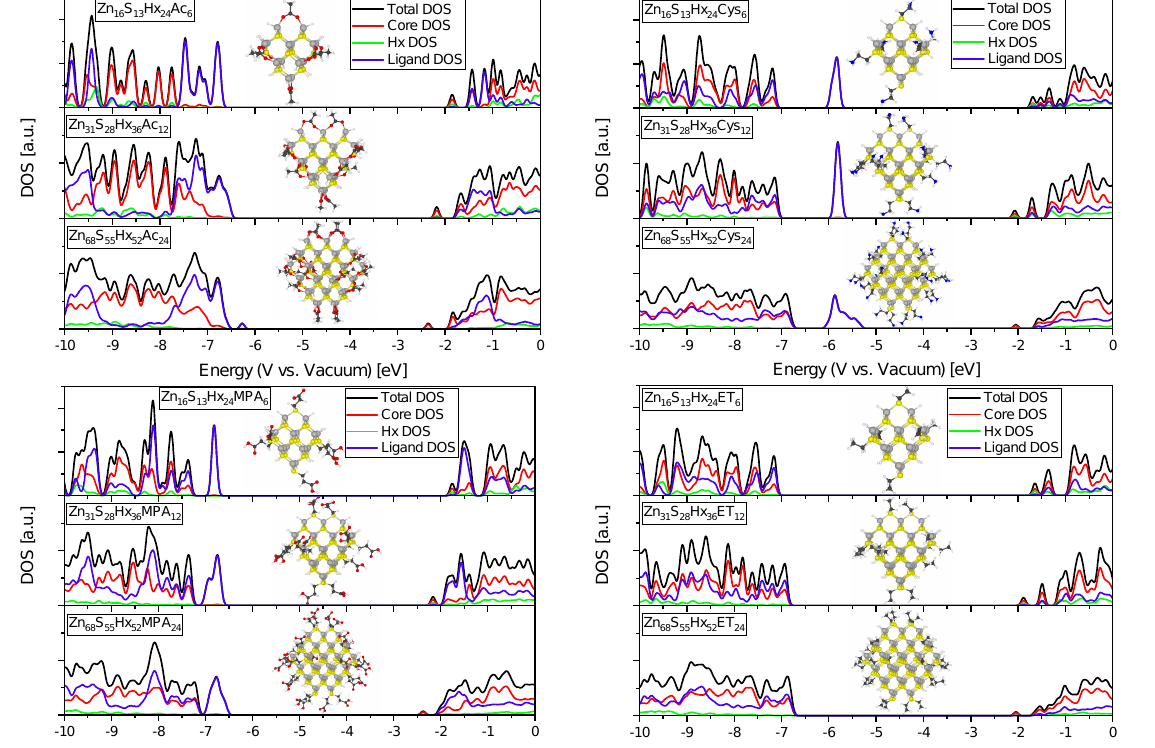
Figure 10. DOS of different sized QDs with various surface passivating ligands (grey: Zn, yellow: S, white: Hx or H, black: C, red: O, blue: N), Acetate ( top left ), Cysteamine ( top right ), 3-Mercaptopropionic acid ( bottom left ) and Ethanethiol ( bottom right